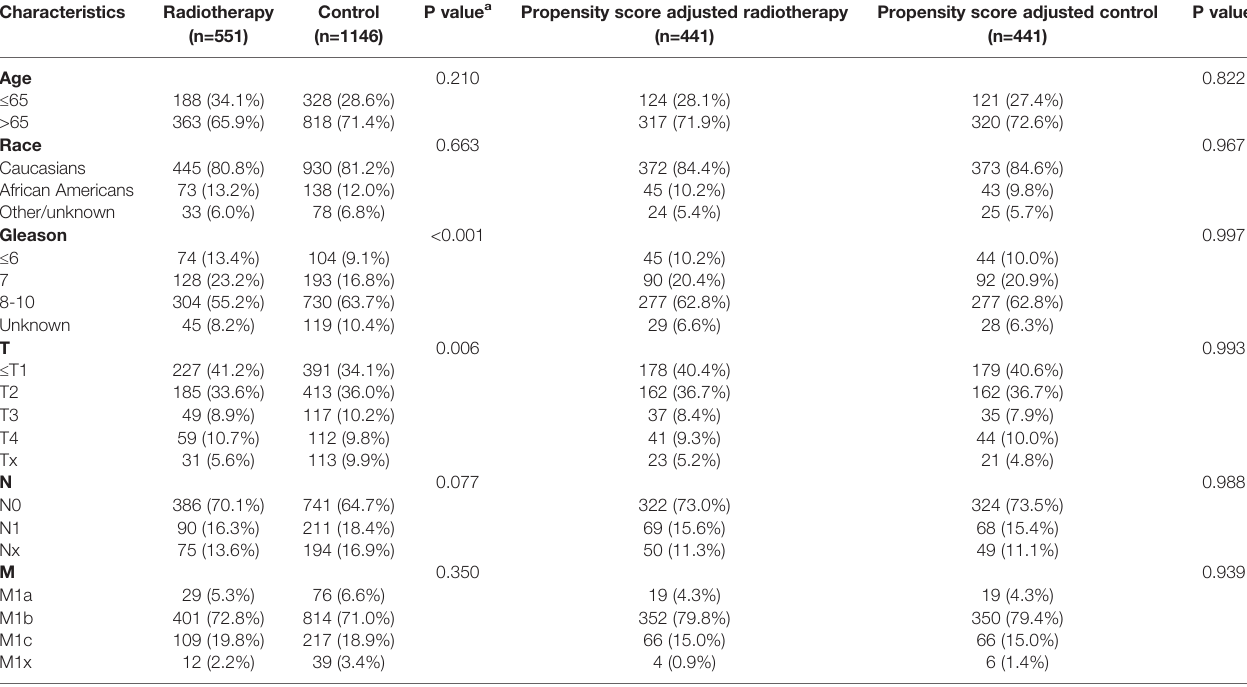
TABLE 4 | Clinicopathological characteristics of the PSA 4.1-10 ng/ml subgroup strati fi ed according to treatment modality with and without propensity score matching.